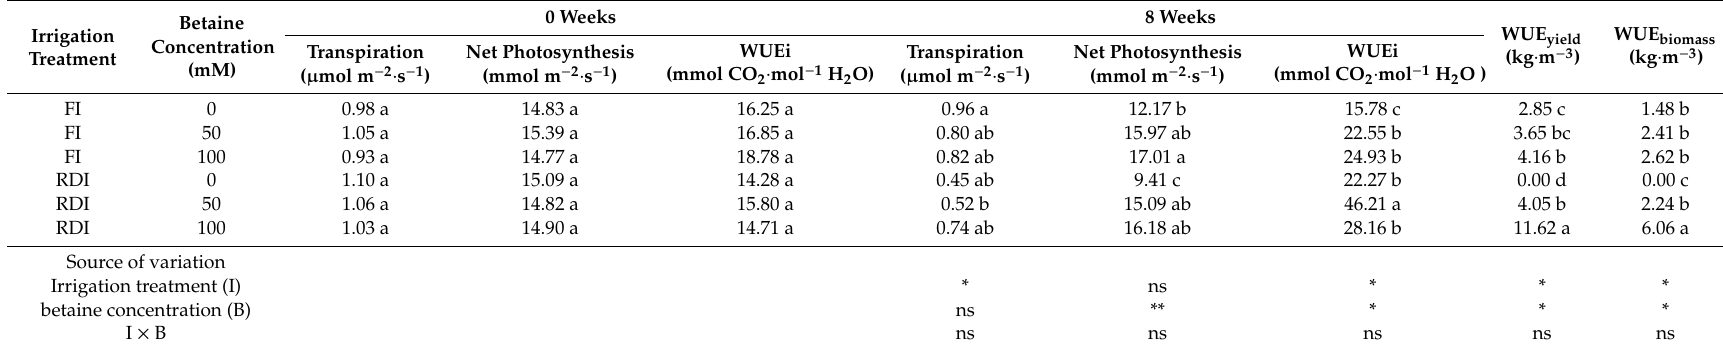
Table 2. E ff ects of di ff erent concentrations of betaine on the photosynthesis and water use e ffi ciency (WUE i , WUE yield , WUE biomass ) of maize under full irrigation (FI) and regulated deficit irrigation